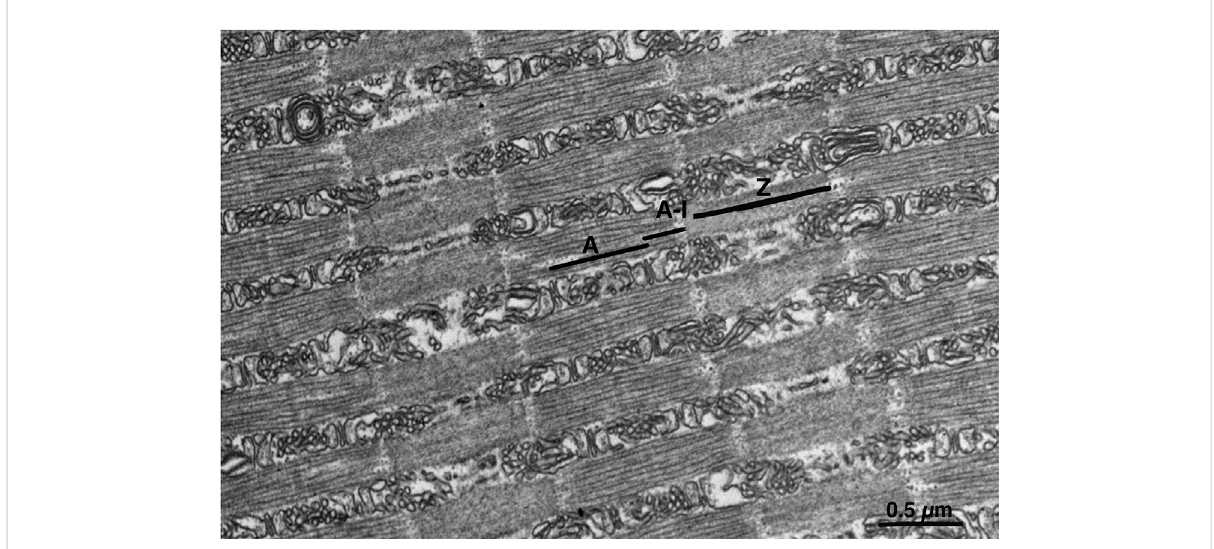
FIGURE 2 RepresentativeEMimageshowingsarcomericbandregionsinlongitudinalsection.DuetothepositionoftriadswithintheAbandregionandto the extended Z lines (see Figure 1), the myo fi brils ’ surface is divided into three domains, each associated with de fi ned portion of the sarcoplasmic reticulum network. One domain (A) covers the center regions of the A band between the triads. A second zone (A – I) covers the lateral thirds of the A band, the I band and the edges of the Z line. A third zone (Z) surrounds the myo fi bril at the level of the wide Z line. Z line. Scale bar: 0.5 μ